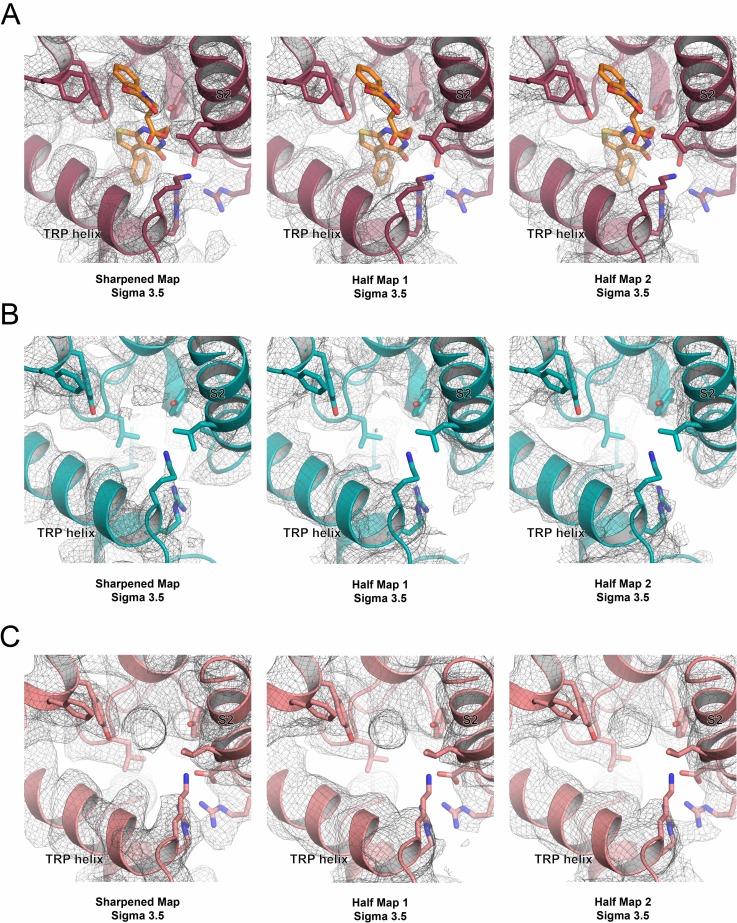
Cryo-EM half maps of intracellular S1-S4 bundle binding pocket.(A) The intracellular S1-S4 bundle binding pocket in the sharpened map (left), half map 1 (center) and half map 2 (right) of ZINC17988990-bound TRPV5. One potential pose of bound ZINC17988990 is shown as orange sticks. (B) The intracellular S1-S4 bundle binding pocket in the sharpened map (left), half map 1 (center) and half map 2 (right) of ZINC9155420-bound TRPV5. (C) The intracellular S1-S4 bundle binding pocket in the sharpened map (left), half map 1 (center) and half map 2 (right) of lipid-bound TRPV5 (PDB: 6DMR, EMB-7965). The density maps are shown as gray mesh.